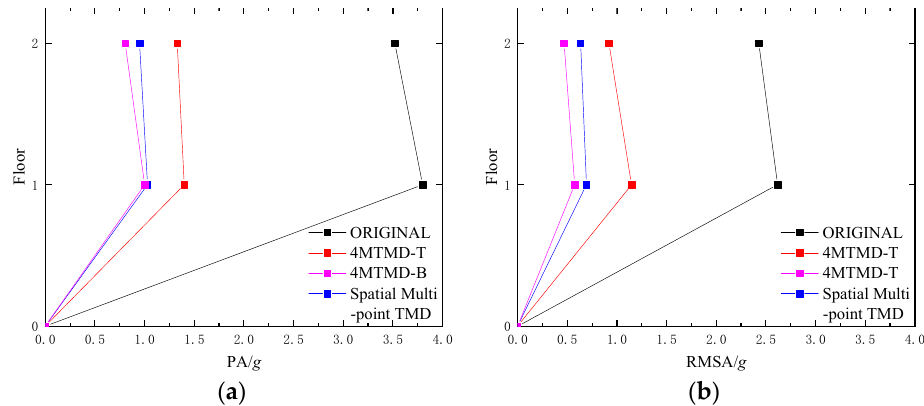
Figure 9. Structural responses of original structure and structures with various TMD control strategies under simple harmonic excitation at various positions: ( a ) peak acceleration and ( b ) RMS acceleration.